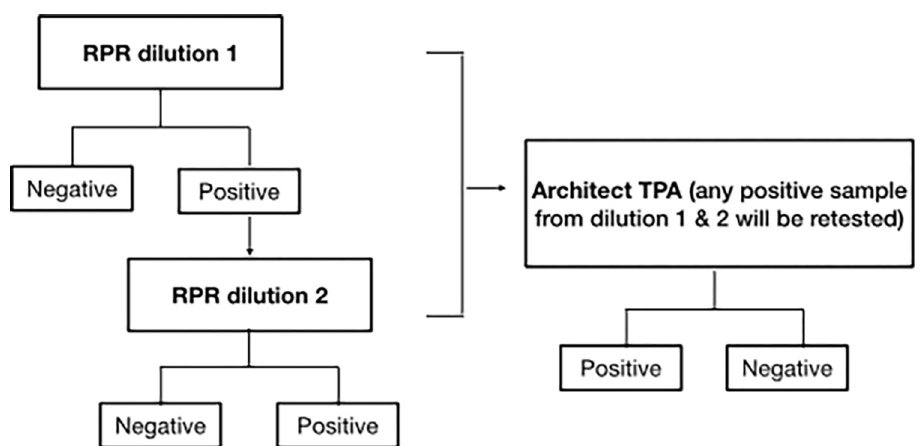
Fig 2. A chart summary of syphilis diagnosis